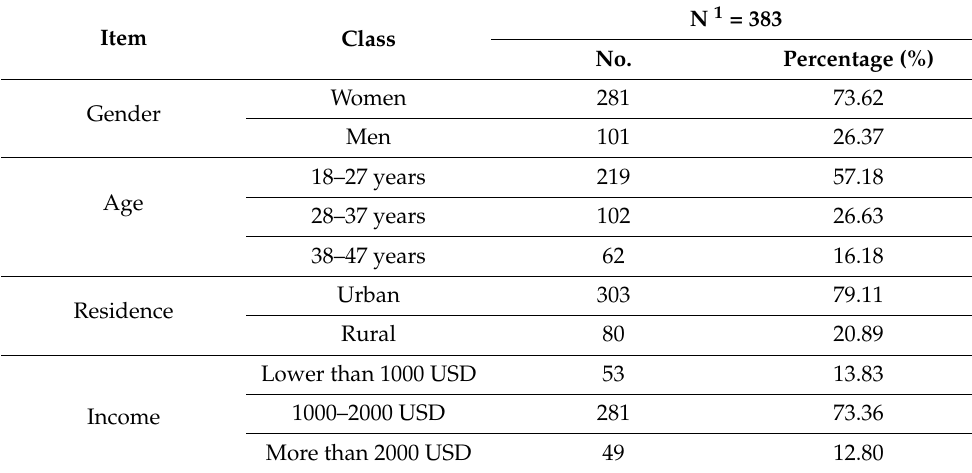
Table 1. Summarizing the demographics of the sample.